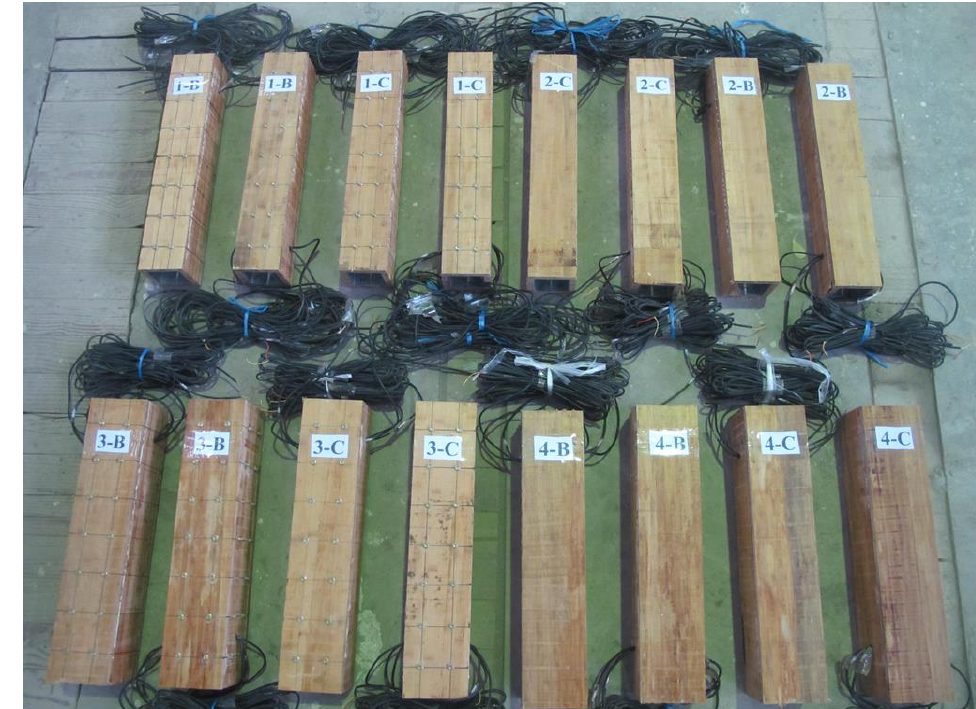
Figure 2. Specimens of composite column.